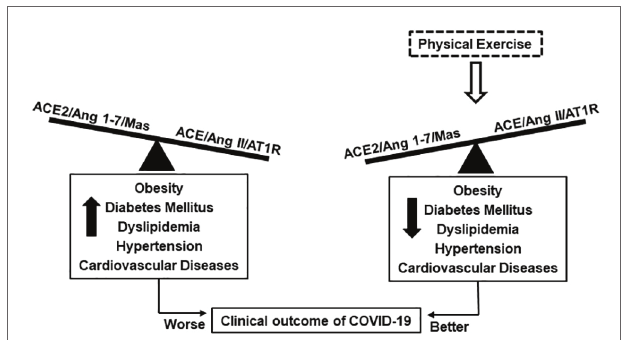
FIGURE 2 | Possible effect of physical exercise in Coronavirus disease 2019 (COVID-19) can be associated with changes in the balance of RAS axes. The unbalance of the RAS is observed in individuals with cardiometabolic diseases, which are more susceptible to severe COVID-19. Physical exercise improves the balance of the RAS toward the protective arm ACE2/Ang 1–7/Mas axis, which is associated with cardiometabolic diseases reduction and possibly better clinical outcome of